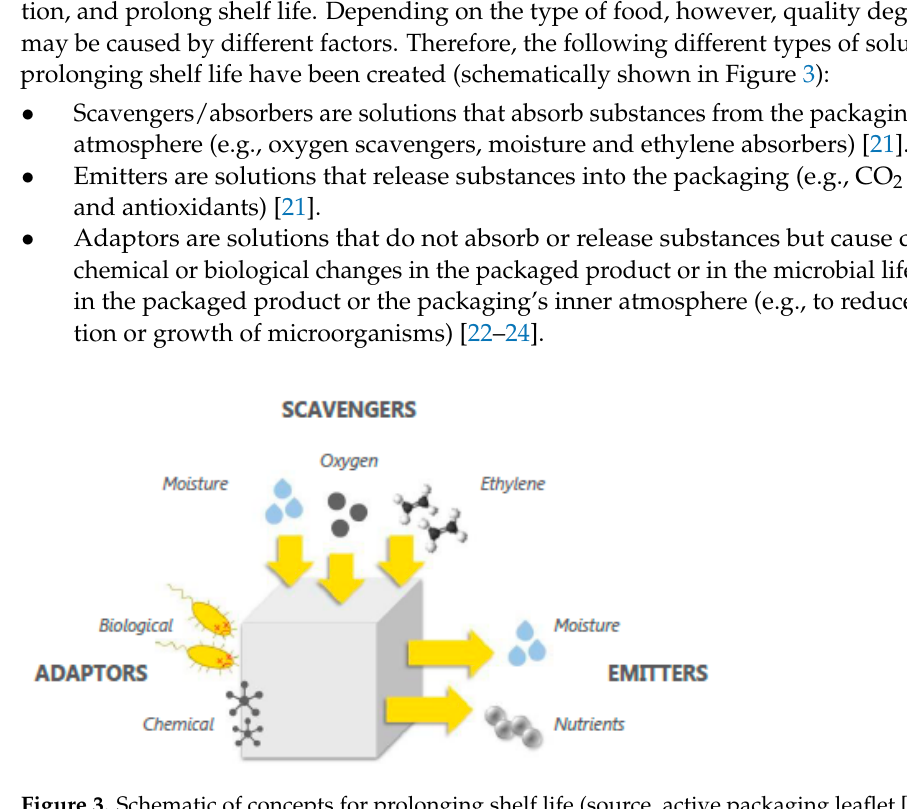
Figure 3. Schematic of concepts for prolonging shelf life (source, active packaging leaflet [25]).